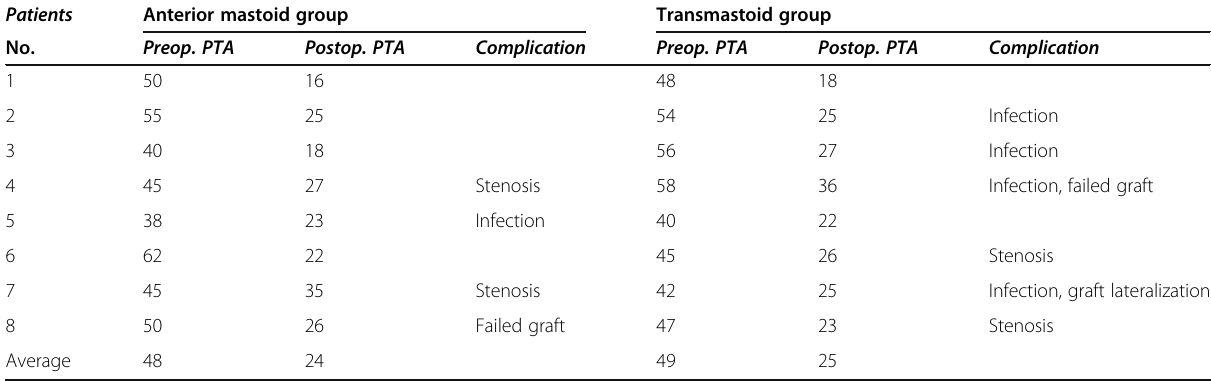
Table 1 Results of anterior mastoid and transmastoid approaches Patients Anterior mastoid